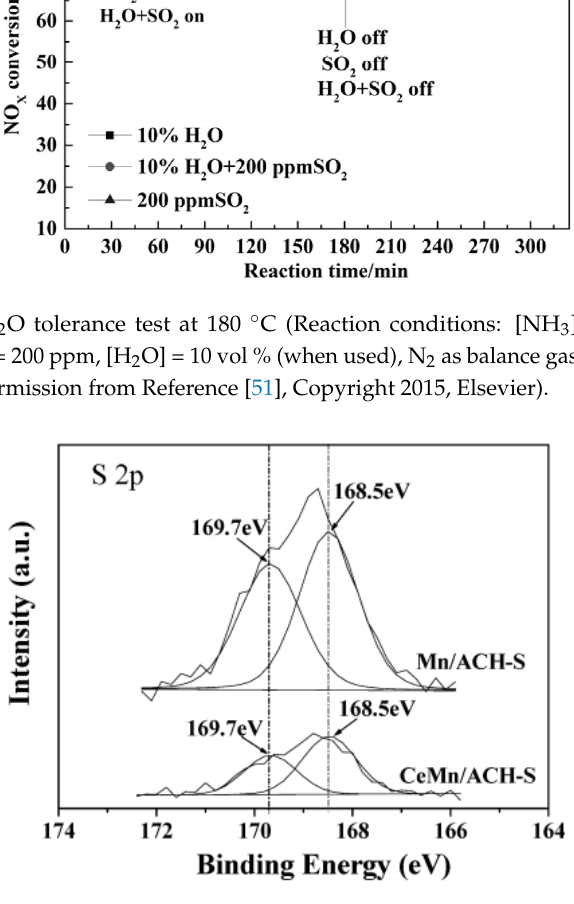
Figure 28. X ‐ ray photoelectron spectroscopy (XPS) spectra of S 2p for poisoned Mn/ACH and CeMn/ACH catalysts. (Reproduced with permission from Reference [81], Copyright 2015, American Chemical Society.).